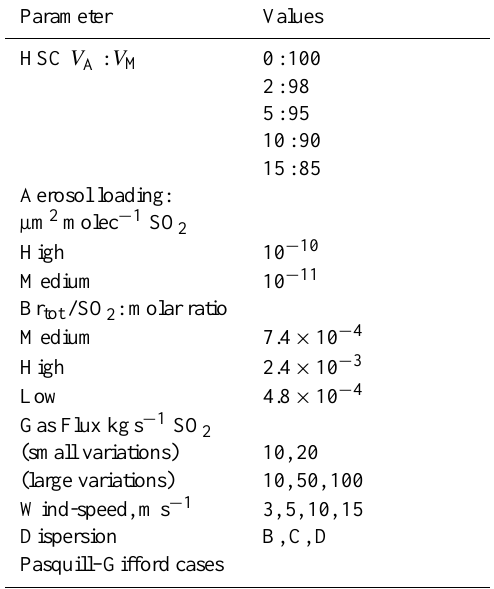
Table 2. Parameters varied in PlumeChem sensitivity